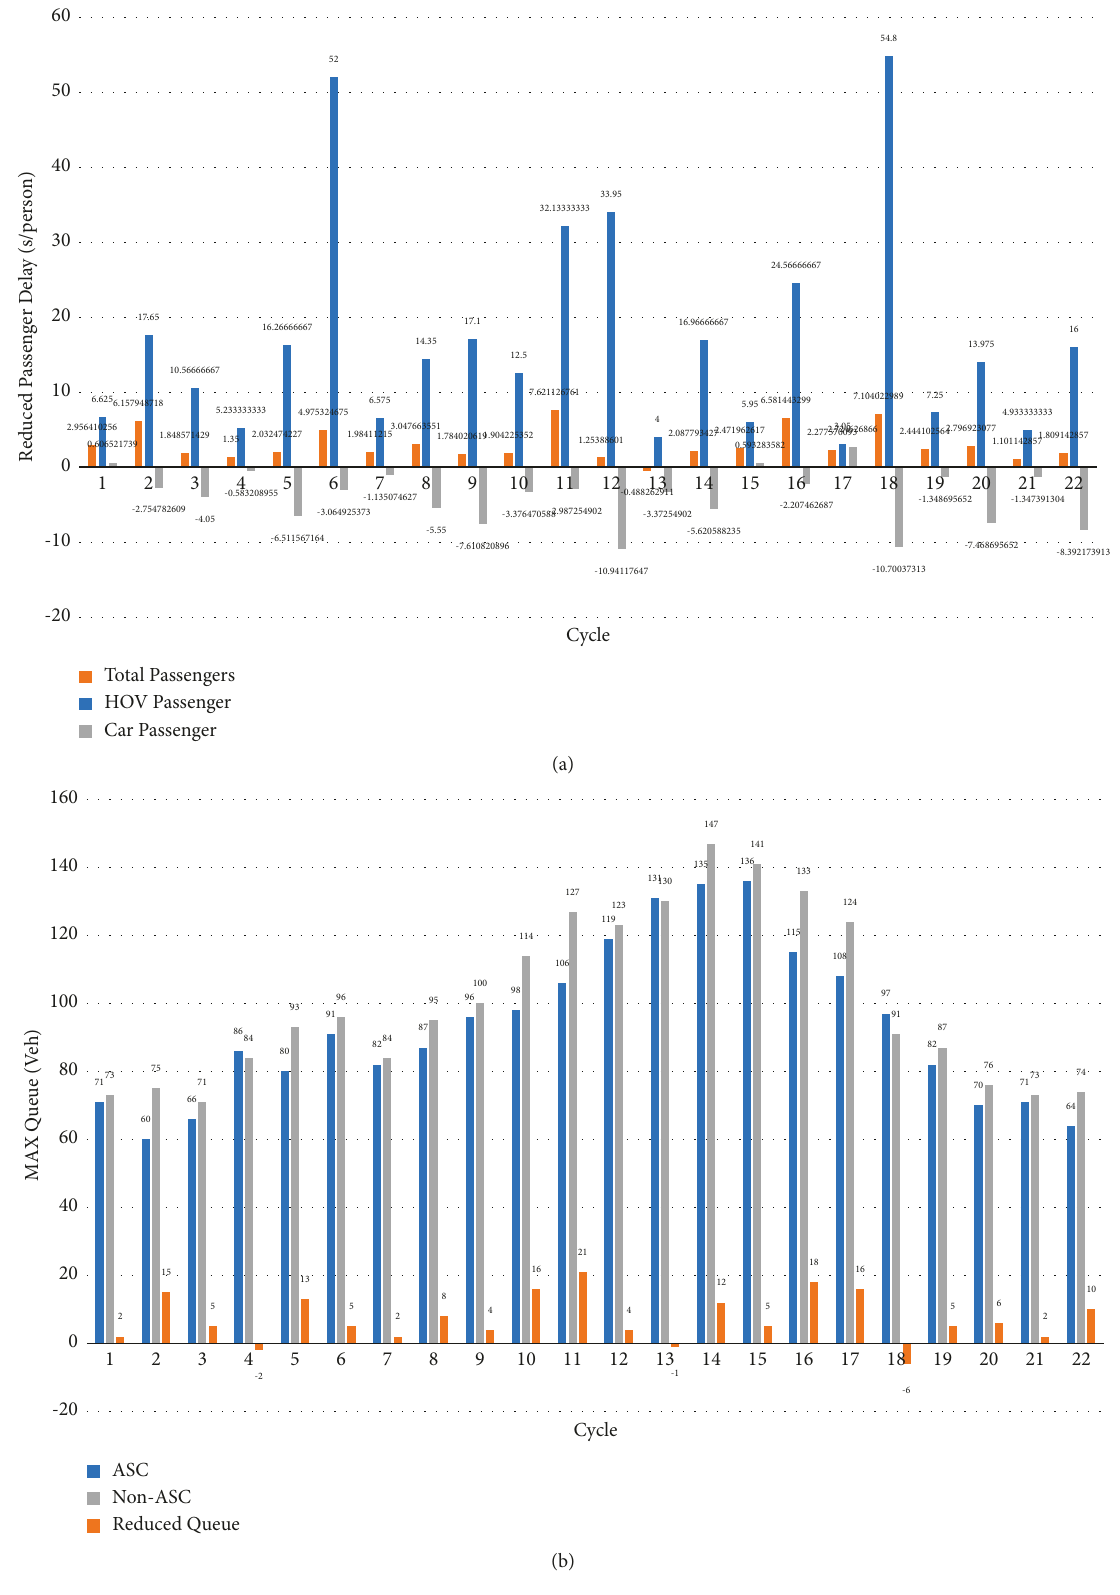
Figure 10: Changes of passenger delays and the maximum queue. (a) Reduced passenger delays. (b) Changes of Max